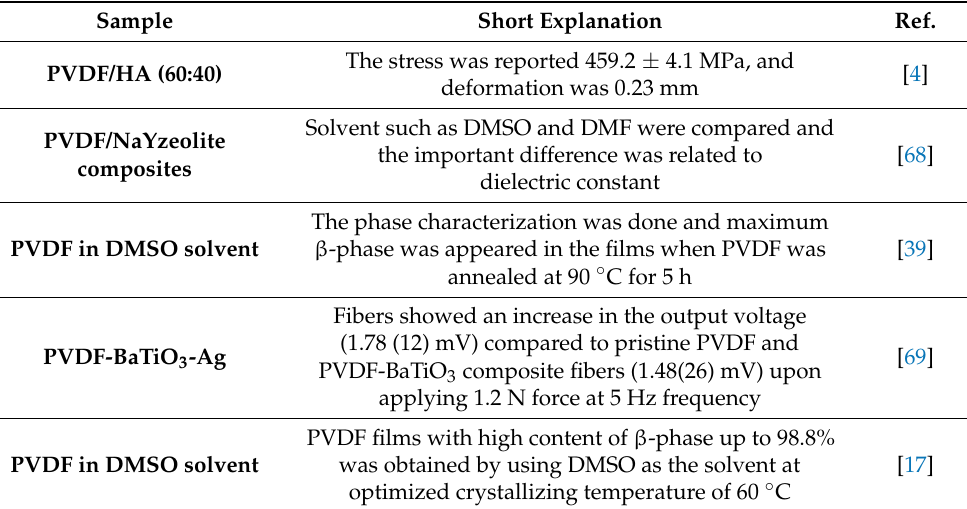
Table 4. Brief comparison of some previous studies on the subject of PVDF composites.